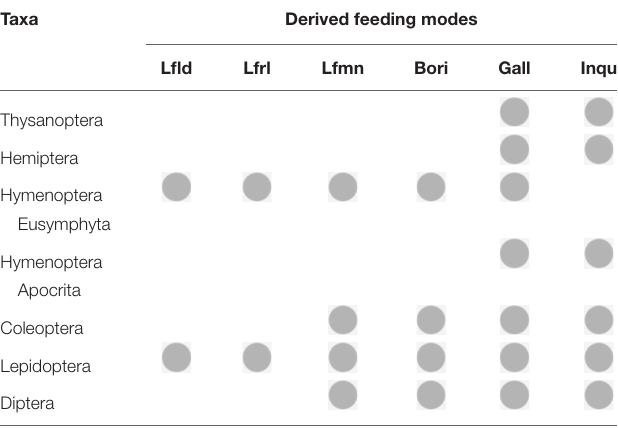
TABLE 2 | Endophagous feeding modes that evolved in each herbivorous